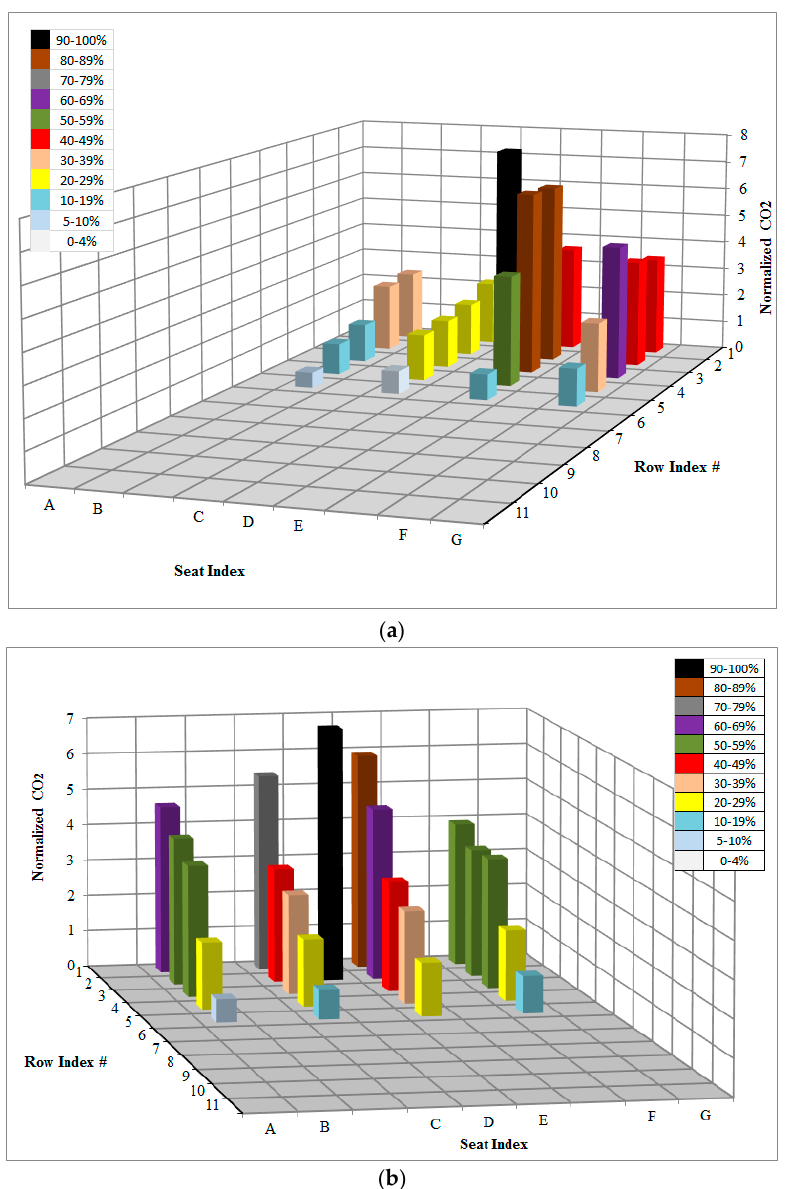
Figure 6. ( a ) normalized CO 2 results for release in seat 2D (1 being at the front side of the cabin)—Heated case; ( b ) normalized CO 2 results for release in seat 2D (1 being at the front side of the cabin)—Unheated case.